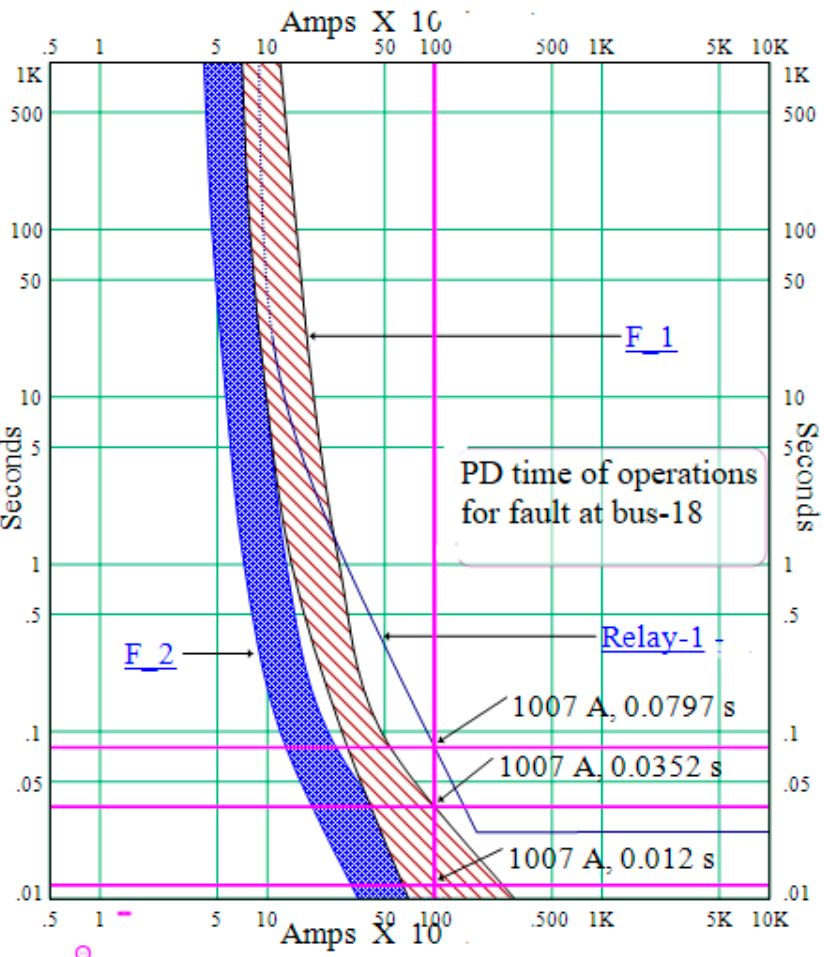
Figure 6. Log–log diagrams of the relay and downstream fuse 1 and fuse 2.